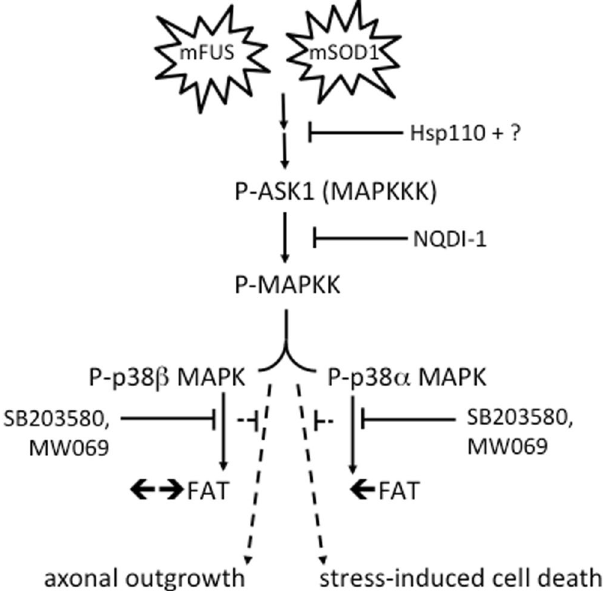
Figure 7. Model for aberrant activation of p38 MAP kinase(s) by mutant and misfolded ALS-associated proteins. Available data (from this study and others 10, 12, 20 ) support a model whereby mutant and misfolded forms of FUS (mFUS; left) and SOD1 (mSOD1; right) induce the aberrant activation of the p38 MAPK pathway. Hsp110 likely synergizes with other chaperones to ameliorate the effects of mSOD1 and mFUS, possibly upstream of ASK1 and additional unidentified factors. While mSOD1 and mFUS converge on p38 MAPK activation, perfusion of these proteins into squid axoplasm have differential effects on FAT; mFUS inhibits both anterograde ( ← ) and retrograde ( → ) FAT (Figs 1 and 2) whereas mSOD1 only inhibits anterograde FAT 10, 12, 20 , consistent with inhibition of the beta and alpha isoforms of P38 MAPK, respectively 12 . In addition to FAT inhibition in squid (solid lines), mFUS- and mSOD1-induced activation p38 MAPK can manifest different phenotypes in mammalian systems (dashed lines), including but not limited to inhibition of axon outgrowth (Fig. 4) and enhanced susceptibility to cell stress 12 . This figure is adapted from Song et al. 20